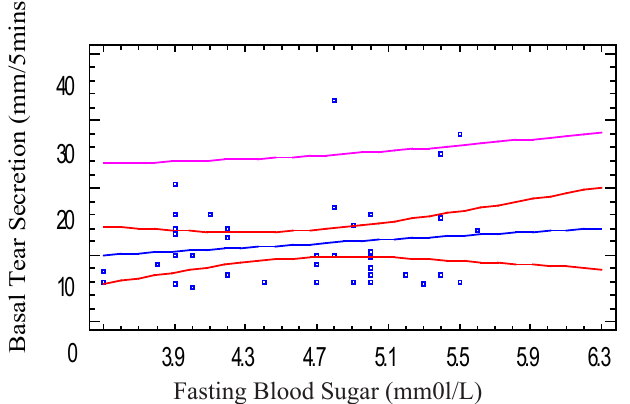
Figure 4 : Relationship between fasting blood sugar and total tear secretion in the control group.